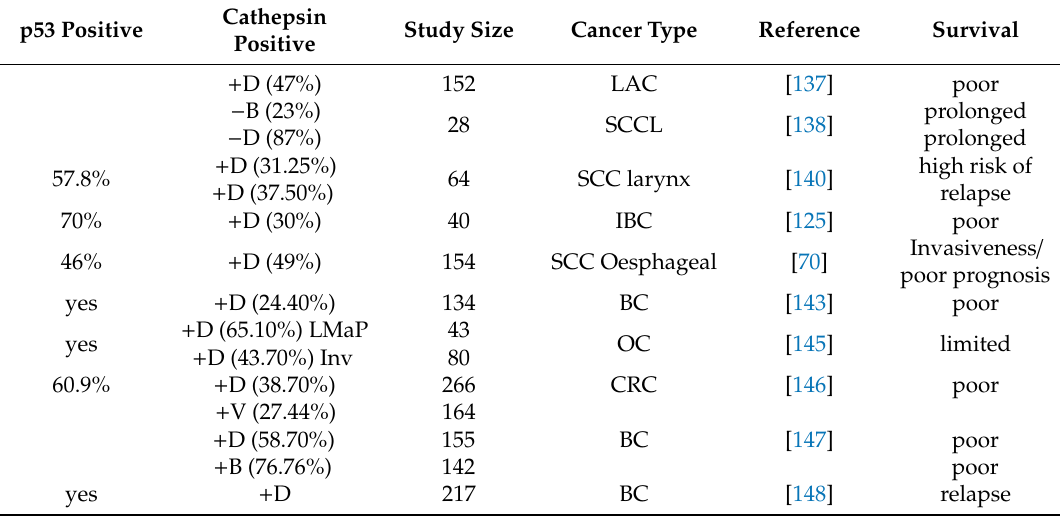
Table 2. Prognostic and diagnostic analysis of p53 and cathepsin gene expression. Patient samples were evaluated for p53 and cathepsin expression using immunohistochemistry or flow cytometry analysis in a variety of cancer types and statistically assessed for correlations in patient survival. + D (increase cathepsin D expression); − D (decreased cathepsin D expression); % (percentage of